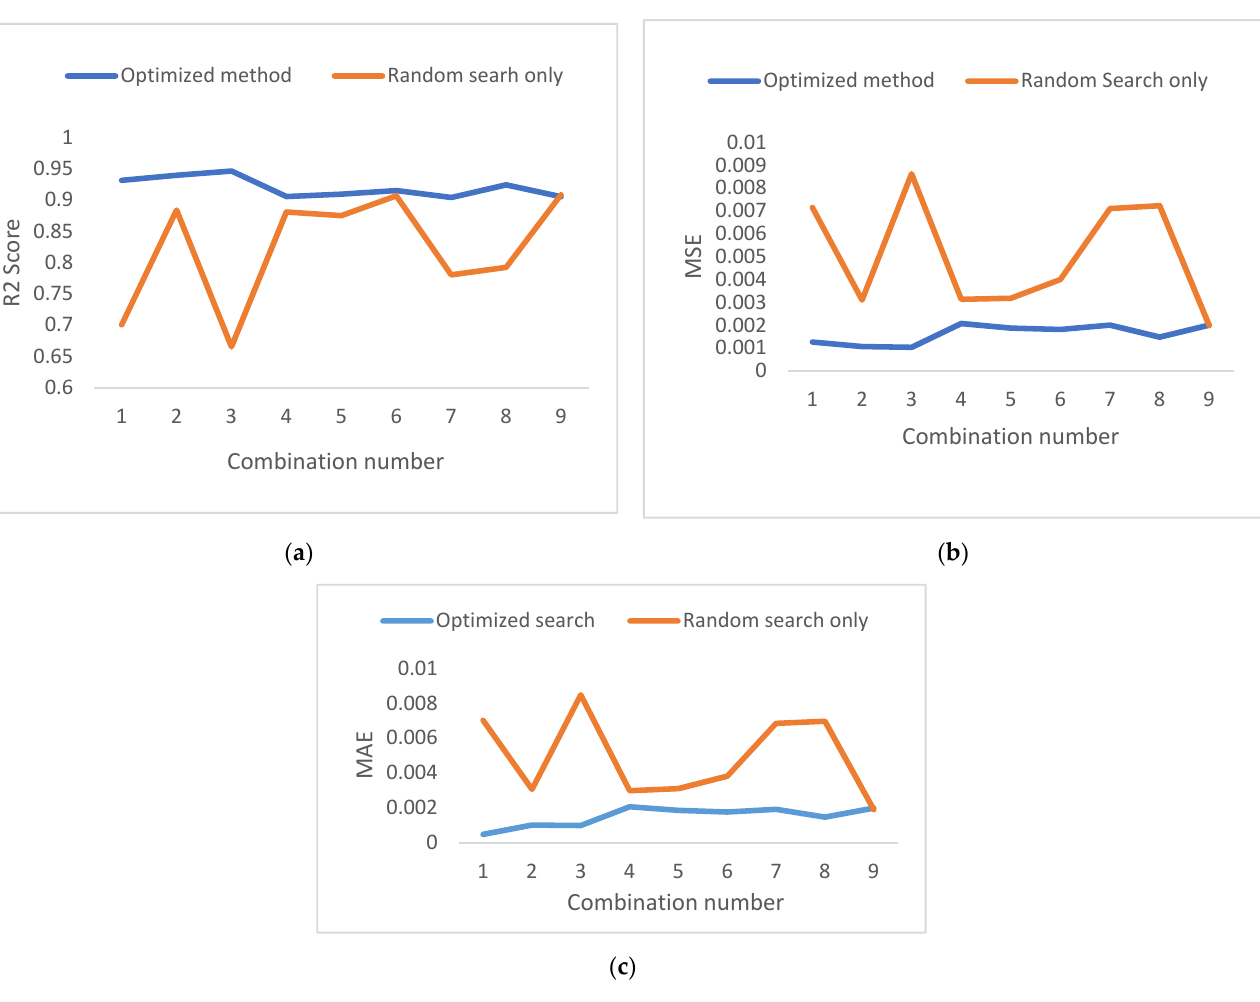
Figure 10. Comparison of the Taguchi method with the random search method for the signals ECGA, ECGP, and LEAD1. ( a ) R 2 Values, ( b ) MSE Values, ( c ) MAE Values. Table 7. Comparison of the proposed method with the different prediction